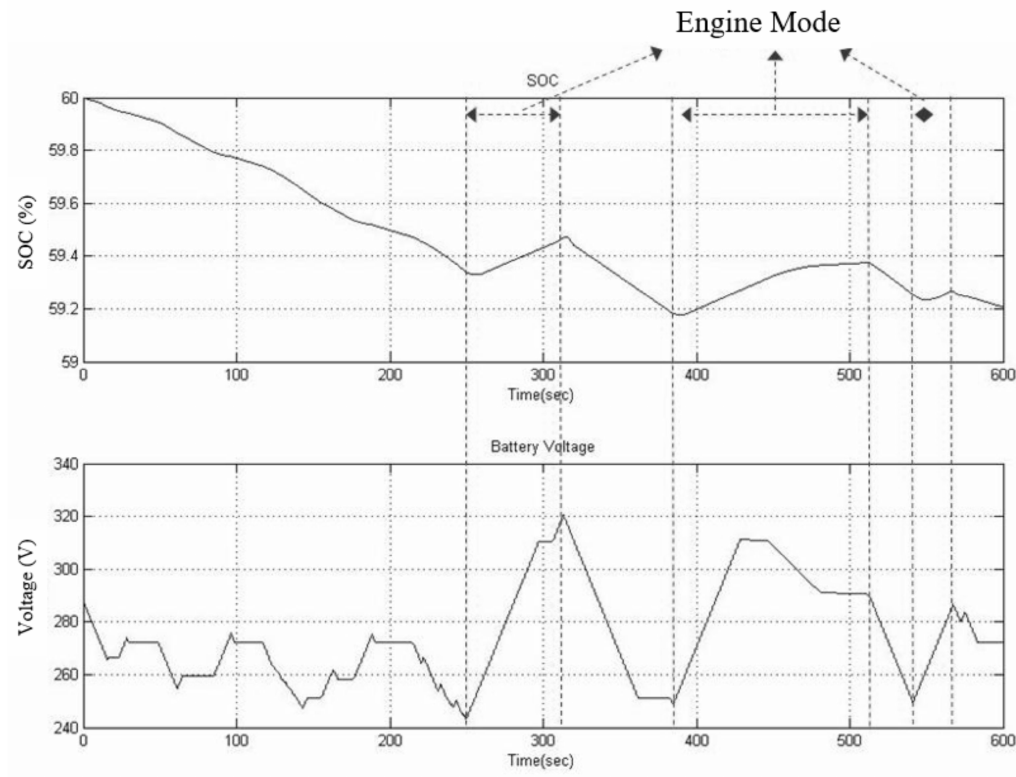
Figure 12. Battery voltage and SOC diagram with the NEDC2000 driving